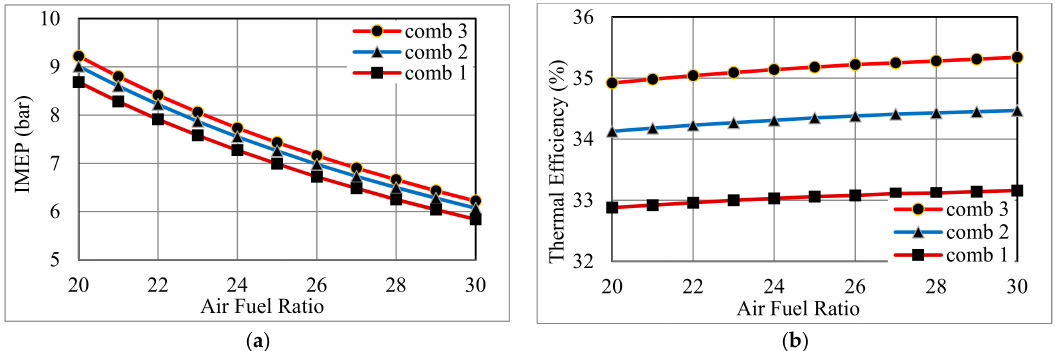
Figure 11. Effects of AFR on the engine output and efficiency of air cycle simulation with three combustion patterns: ( a ) IMEP ; and ( b ) indicated thermal